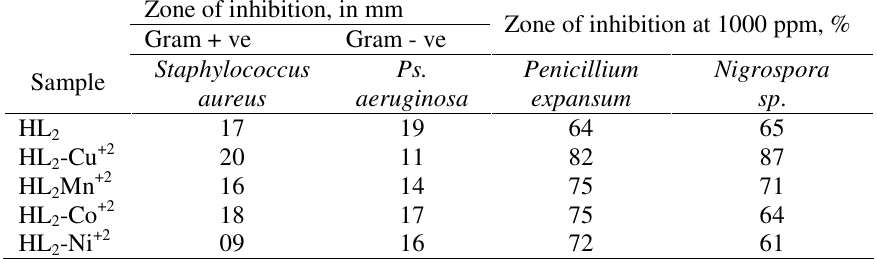
and their metal 2